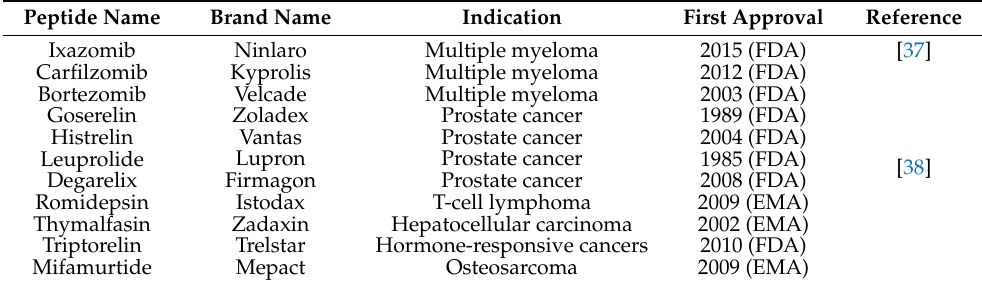
Table 1. List of ACPs approved by FDA and